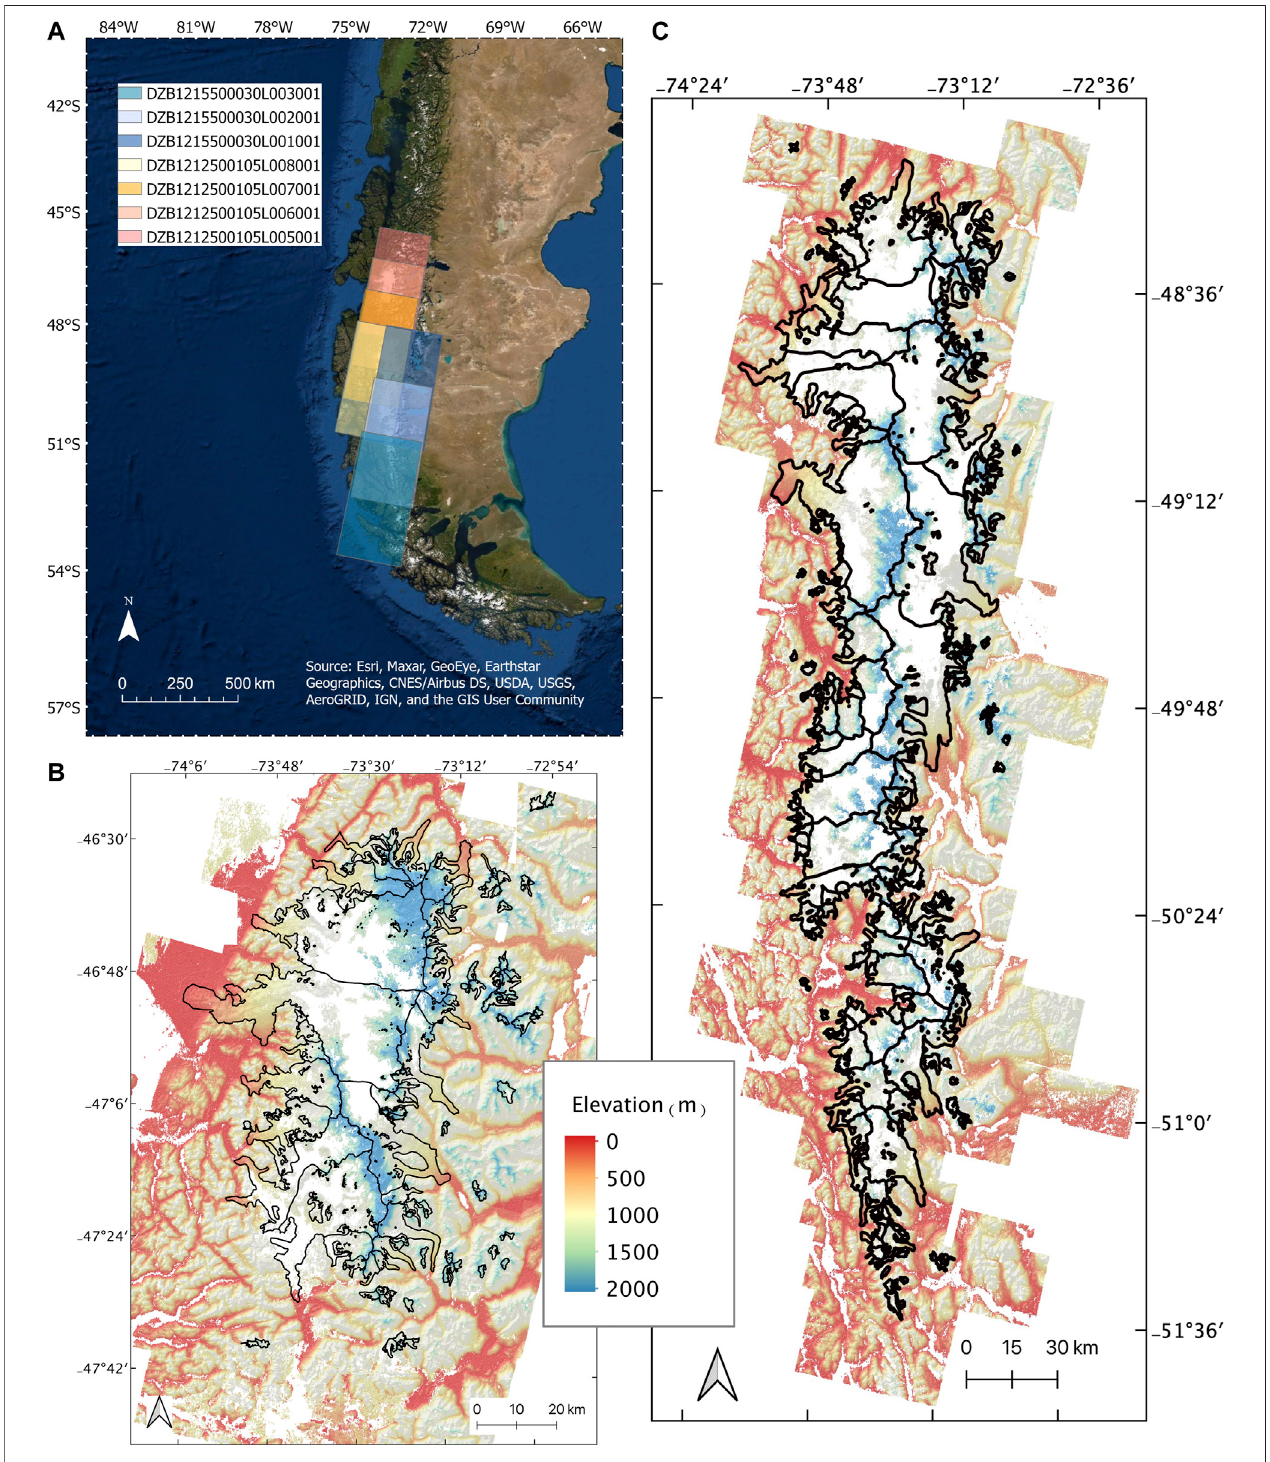
FIGURE 2 | (A) Hexagon DEM footprints; (B) Hexagon DEM generated for the NPI (1976); (C) Hexagon DEM generated for the SPI (1976/1979). Polygons represent the historical extents of glaciers, and white areas are no data.